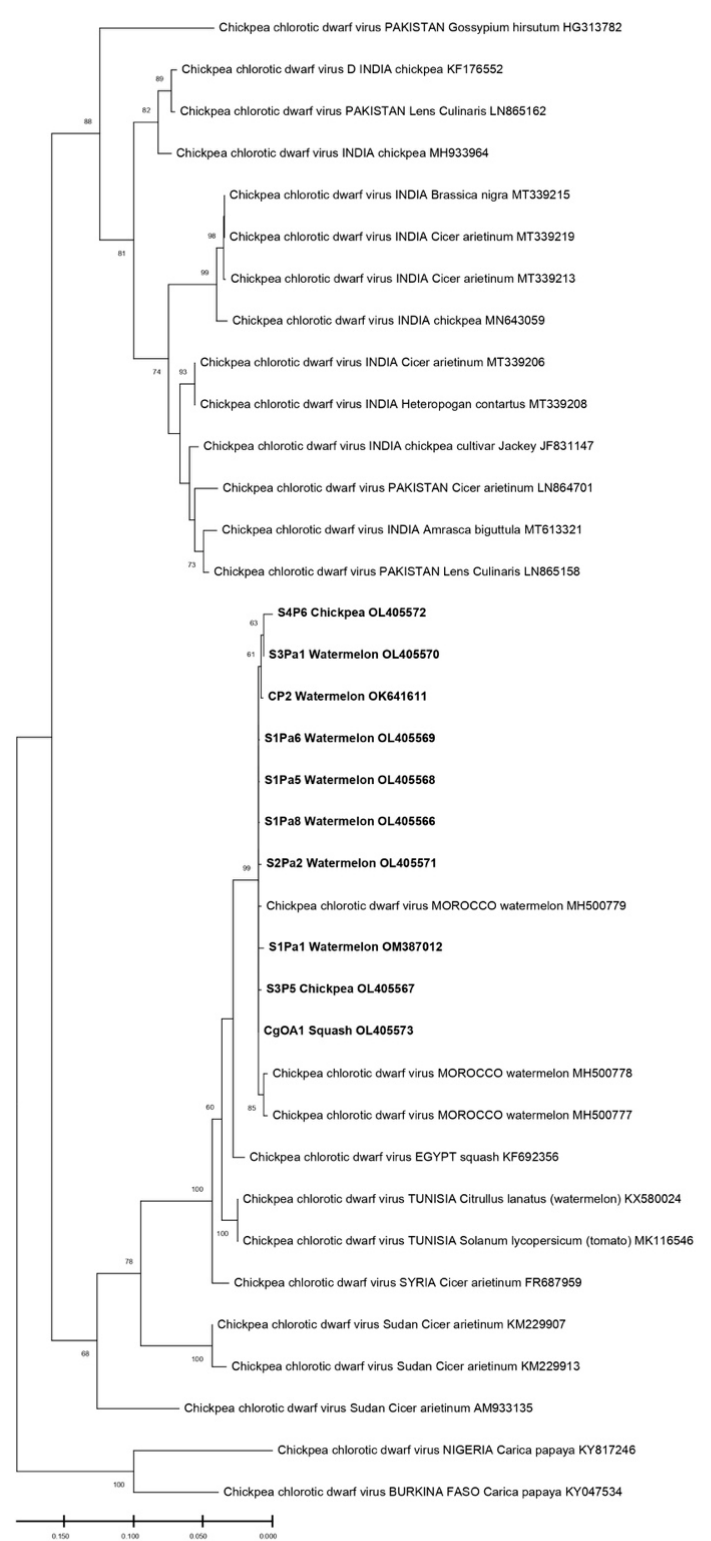
Figure 4. The evolutionary history was inferred by using the Maximum Likelihood method and the Kimura 2-parameter model for the CpCDV. This analysis involved 36 nucleotide sequences for the CpCDV tree; only the results that have branch support above 50% are shown.